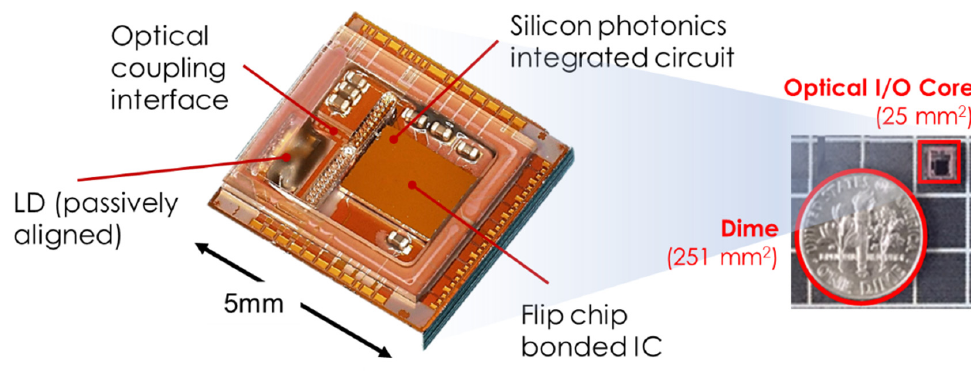
Figure 3. IOCore micro-transceiver footprint of 5 × 5 mm [3] .